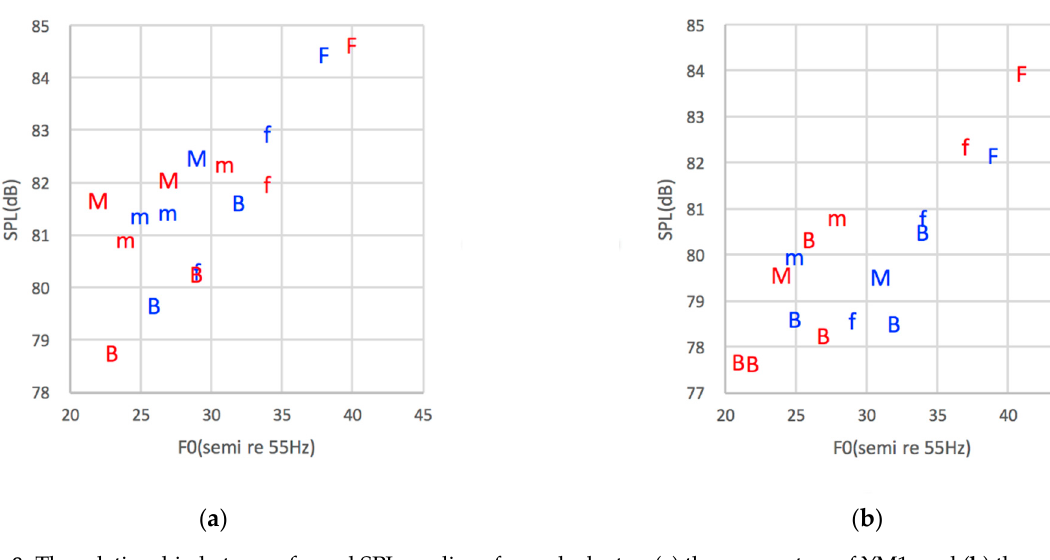
Figure 8. The relationship between f o s and SPL medians for each cluster: ( a ) the parameters of YM1, and ( b ) the parameters of YM2. m: modal; M: high adduction modal; B: breathy; f: untrained falsetto; F: high adduction falsetto. The blue marks represent singing and the red ones represent the stage speech.